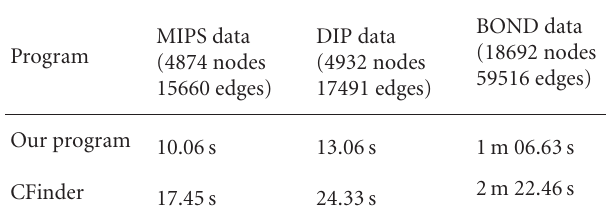
Table 4: Comparison of our method and CFinder in terms of the number of functional categories shared by all the proteins in the groups.